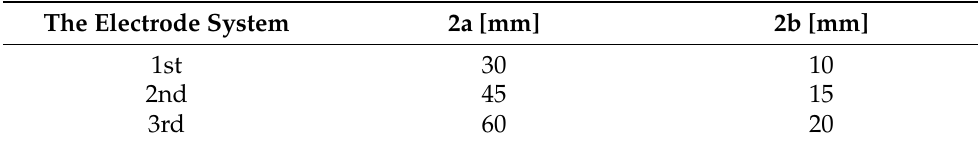
Figure 5. The designed electrode systems: ( a ) the first, ( b ) the second, ( c ) the third. Table 4. The electrode system parameters.